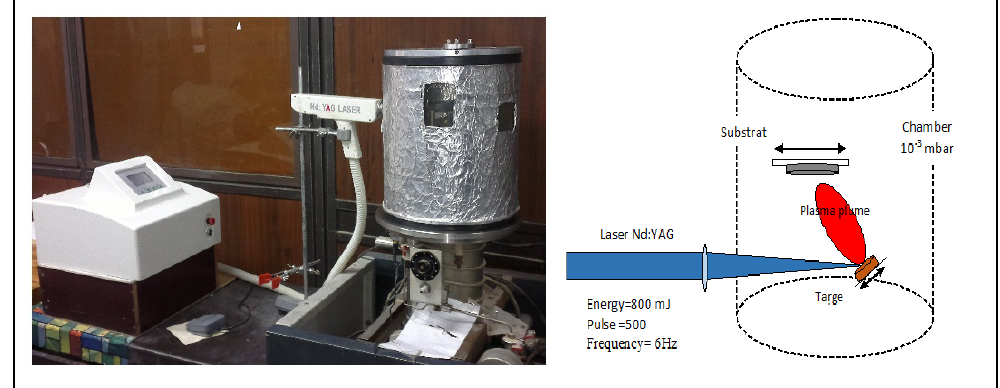
Fig.1: PLD set up using Nd:YAG with λ = (1064